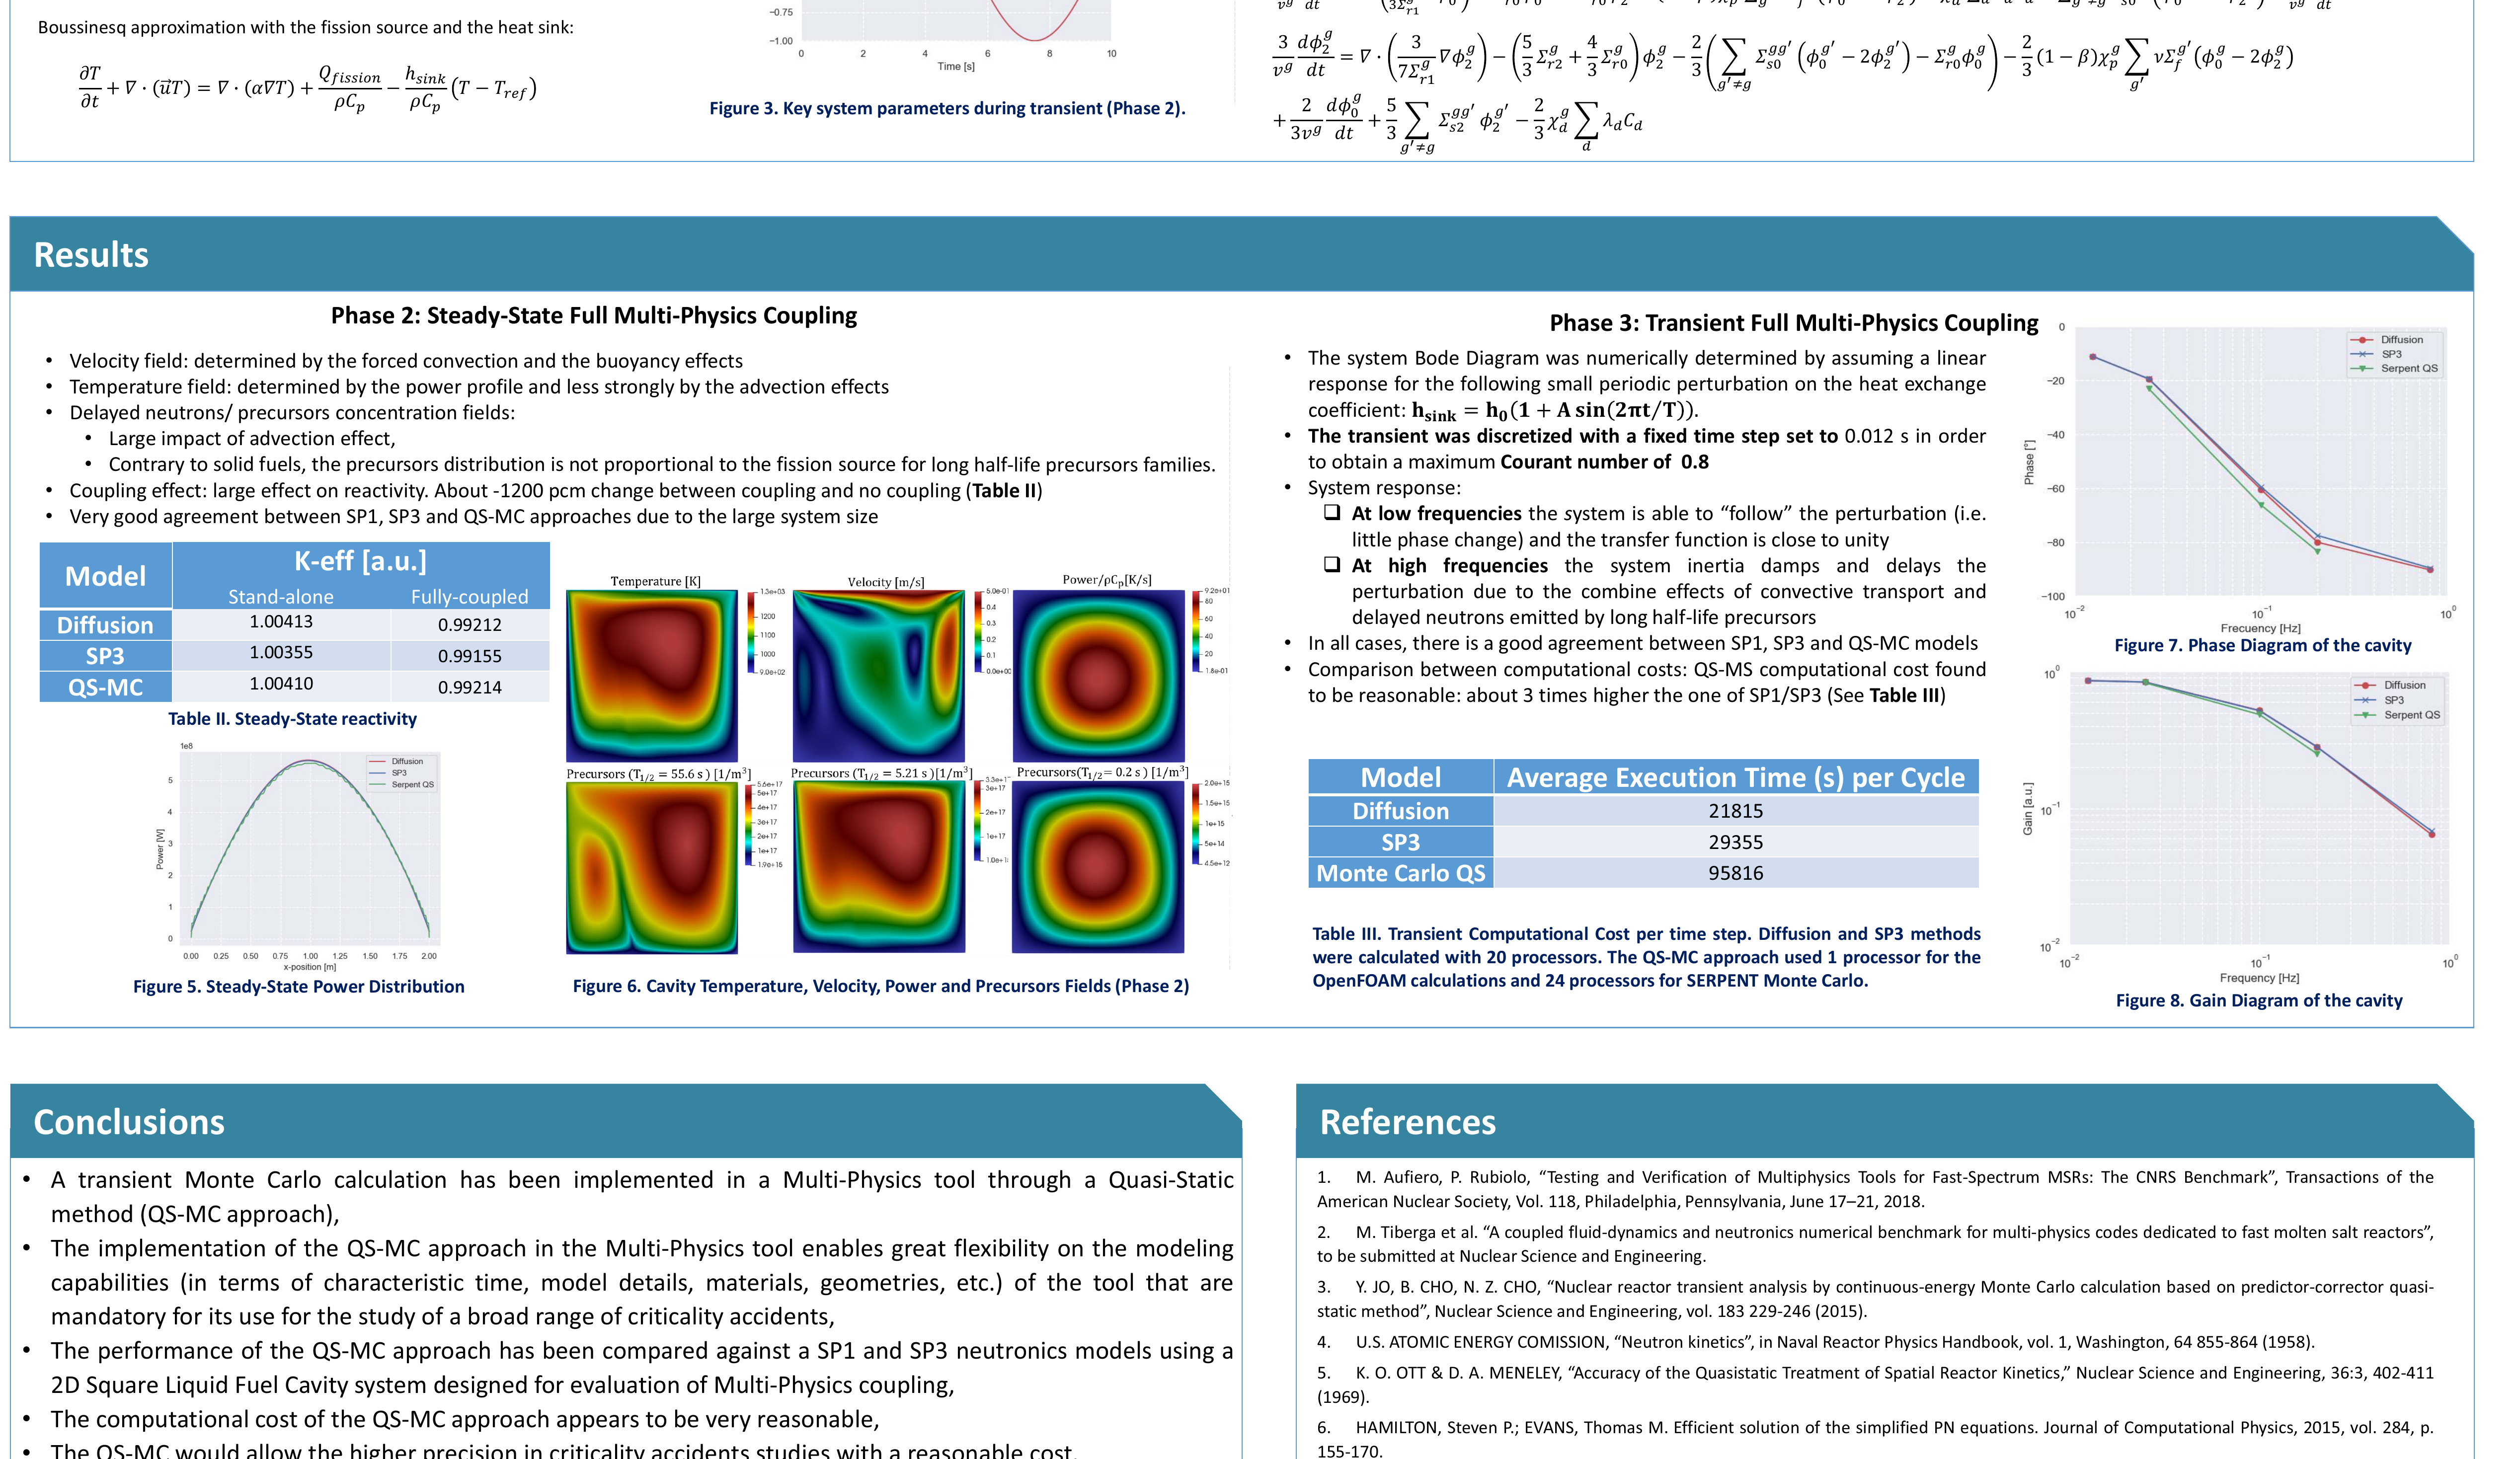
Figure 3. Key system parameters during transient (Phase 2).